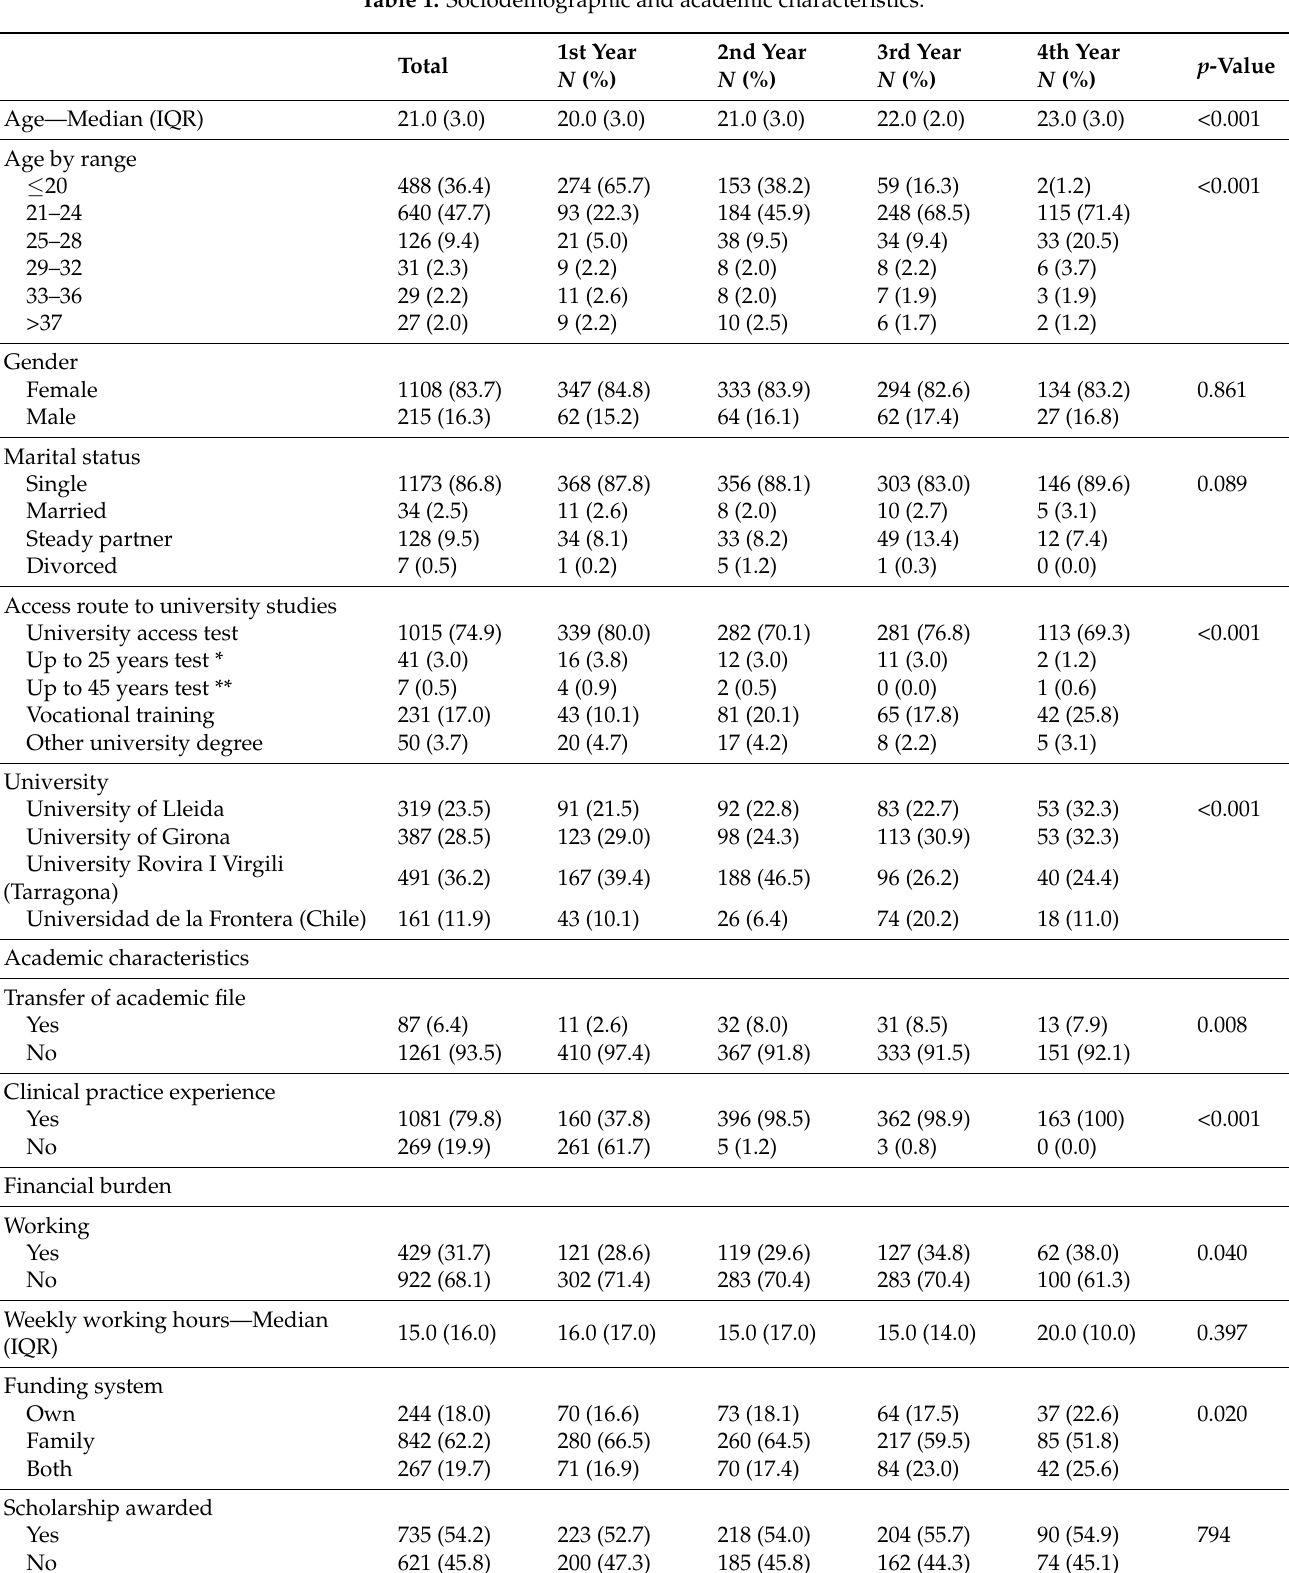
Table 1. Sociodemographic and academic